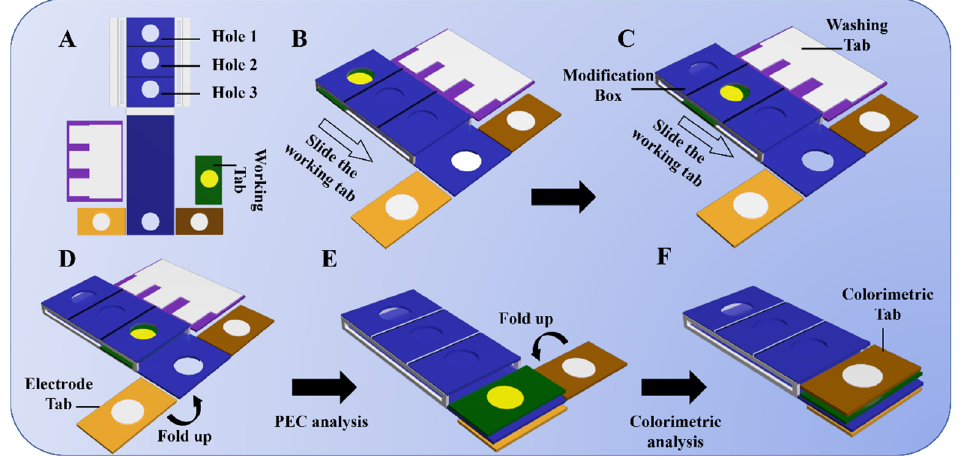
Figure 1. Assembly and operation illustration of the proposed dual-mode lab-on-paper device. ( A ) Unfolded sensor platform, ( B – D ) modification process for PWE of the biosensor platform, ( E ) folding process for PEC detection of target, and ( F ) folding process for colorimetric detection of target.